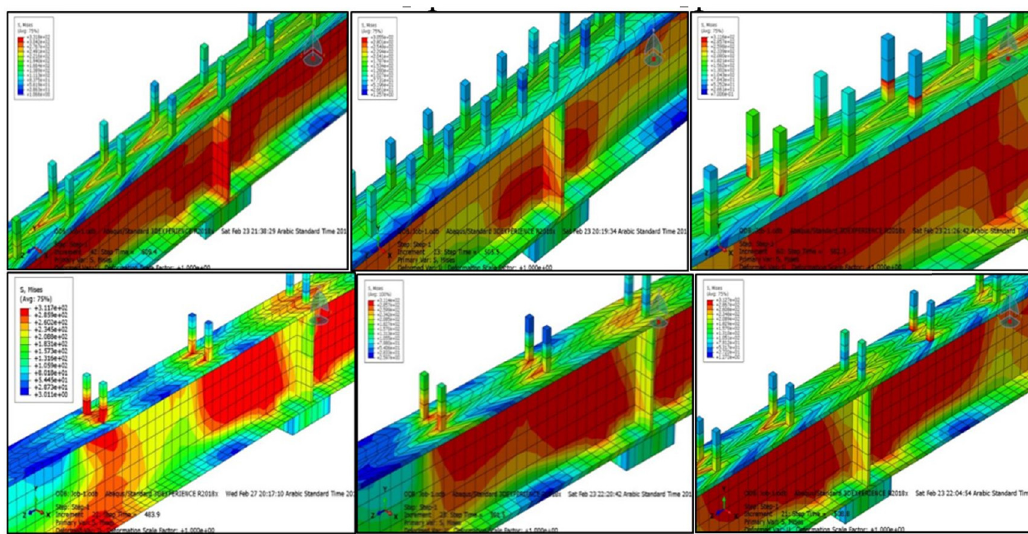
Figure 10: Stress distribution for specimens of Group A.